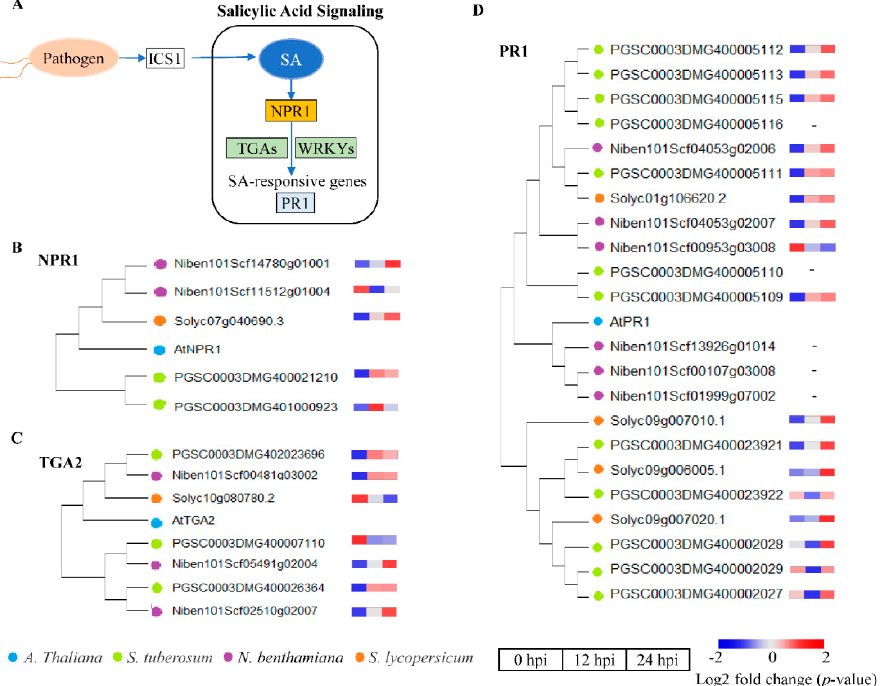
Figure 7. Transcriptional regulation changes of SA signaling pathways related to defense response in TSHs at 0, 12 and 24 hpi infected by P. infestans . ( A ) SA signaling pathway was displayed with Key genes in plant. ( B ) The expression of NPR1 homologous genes in TSHs. ( C ) The expression of TGA2 homologous genes in TSHs. ( D ) The expression of PR1 homologous genes in TSHs. The blue, green, purple and orange dots represent A. thaliana , S. tuberosum , N. benthamiana and S. lycopersicum , respectively. The rectangles represented the expression levels at 0, 12 and 24 h, respectively. The color scale showed the values of log2 fold change ( p -value).